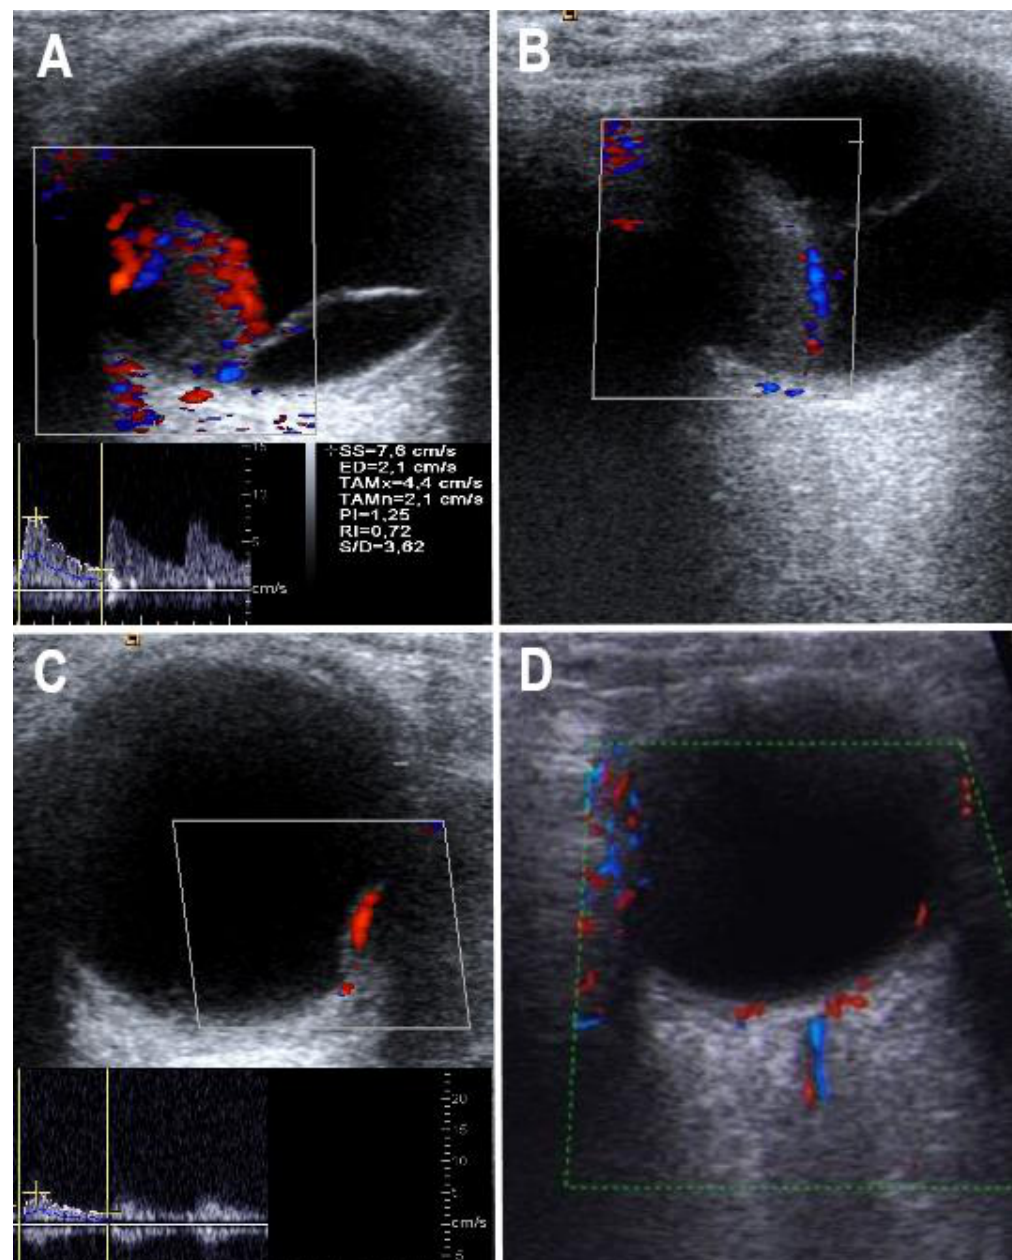
Figure 1. Color Doppler flow imaging of choroidal melanoma before and after therapy. ( A ) Patient with a large choroidal melanoma at inferior nasal location of left eye. Note the high degree of intra-tumor vascularization (level 3). The insert in the lower part shows the CDFI flow curve and indices of a prominent intra-tumor artery. ( B ) Choroidal melanoma 3 months after CyberKnife® therapy in the same patient as shown in ( A ). Note the complete loss of intra-tumor vascularization (level 0), with visibility only of sub-retinal vessels. ( C ) Patient with a small choroidal melanoma at temporal location of right eye. Note the prominent singular intra-tumor artery (vascularization level 2). The insert in the lower part shows the CDFI flow curve of the intra-tumor artery. ( D ) Choroidal melanoma 12 months after CyberKnife® therapy in the same patient as shown in (c). Note the nearly complete loss of intra-tumor vascularization (level 1), with visibility only of a low- flow intra-tumor artery.